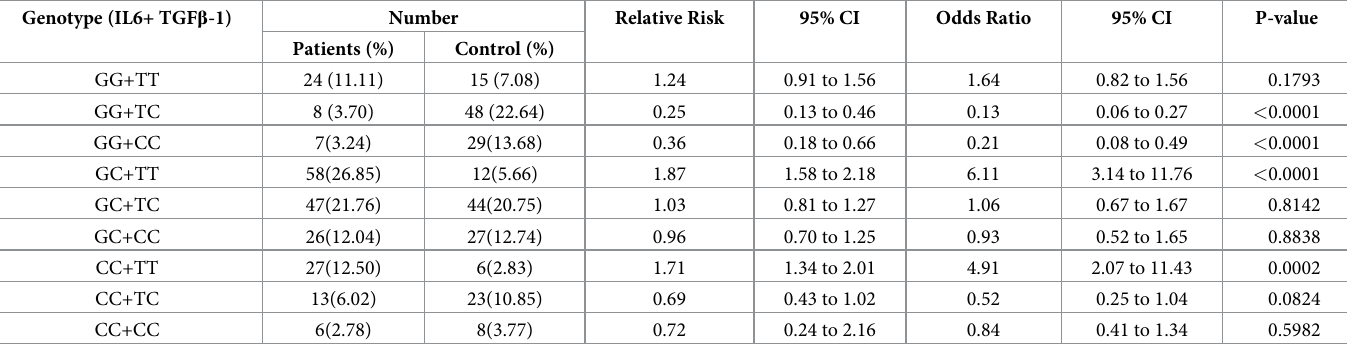
Table 7. TGF β -1 and IL-6 co-existing genotypes, along with their relative risk, odds ratio and p-value in HCV-induced HCC patients. Genotype (IL6+ TGF β -1)